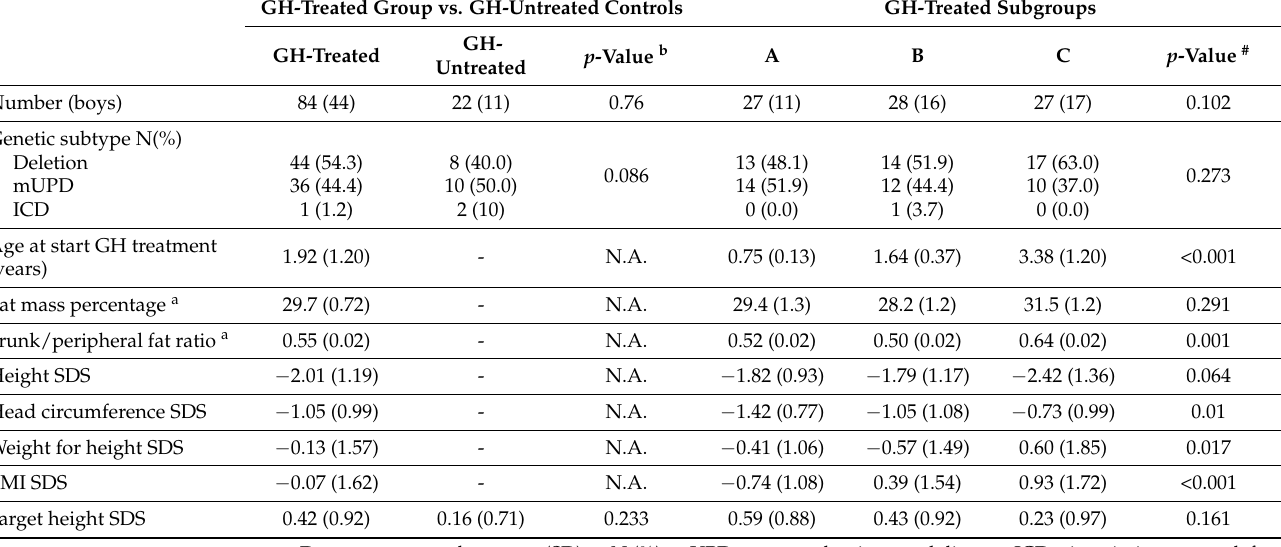
Table 1. Baseline